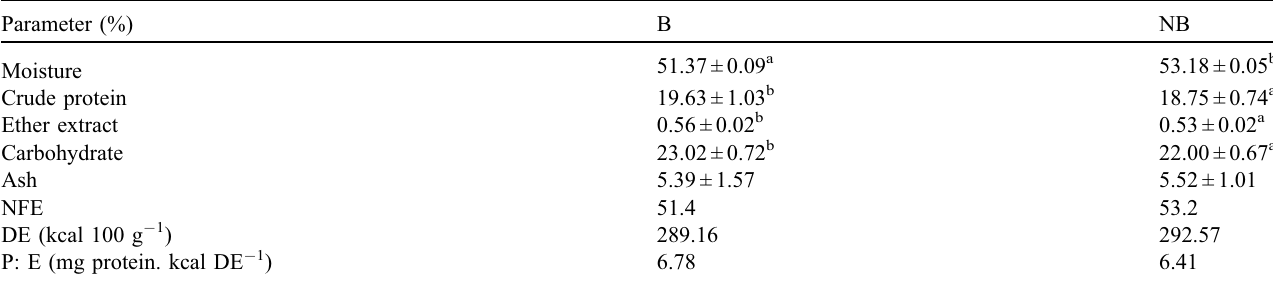
Table 4. Proximate composition (% dry matter basis) of bio fl oc in different pond treatments (mean±standard error; n = 3). Parameter